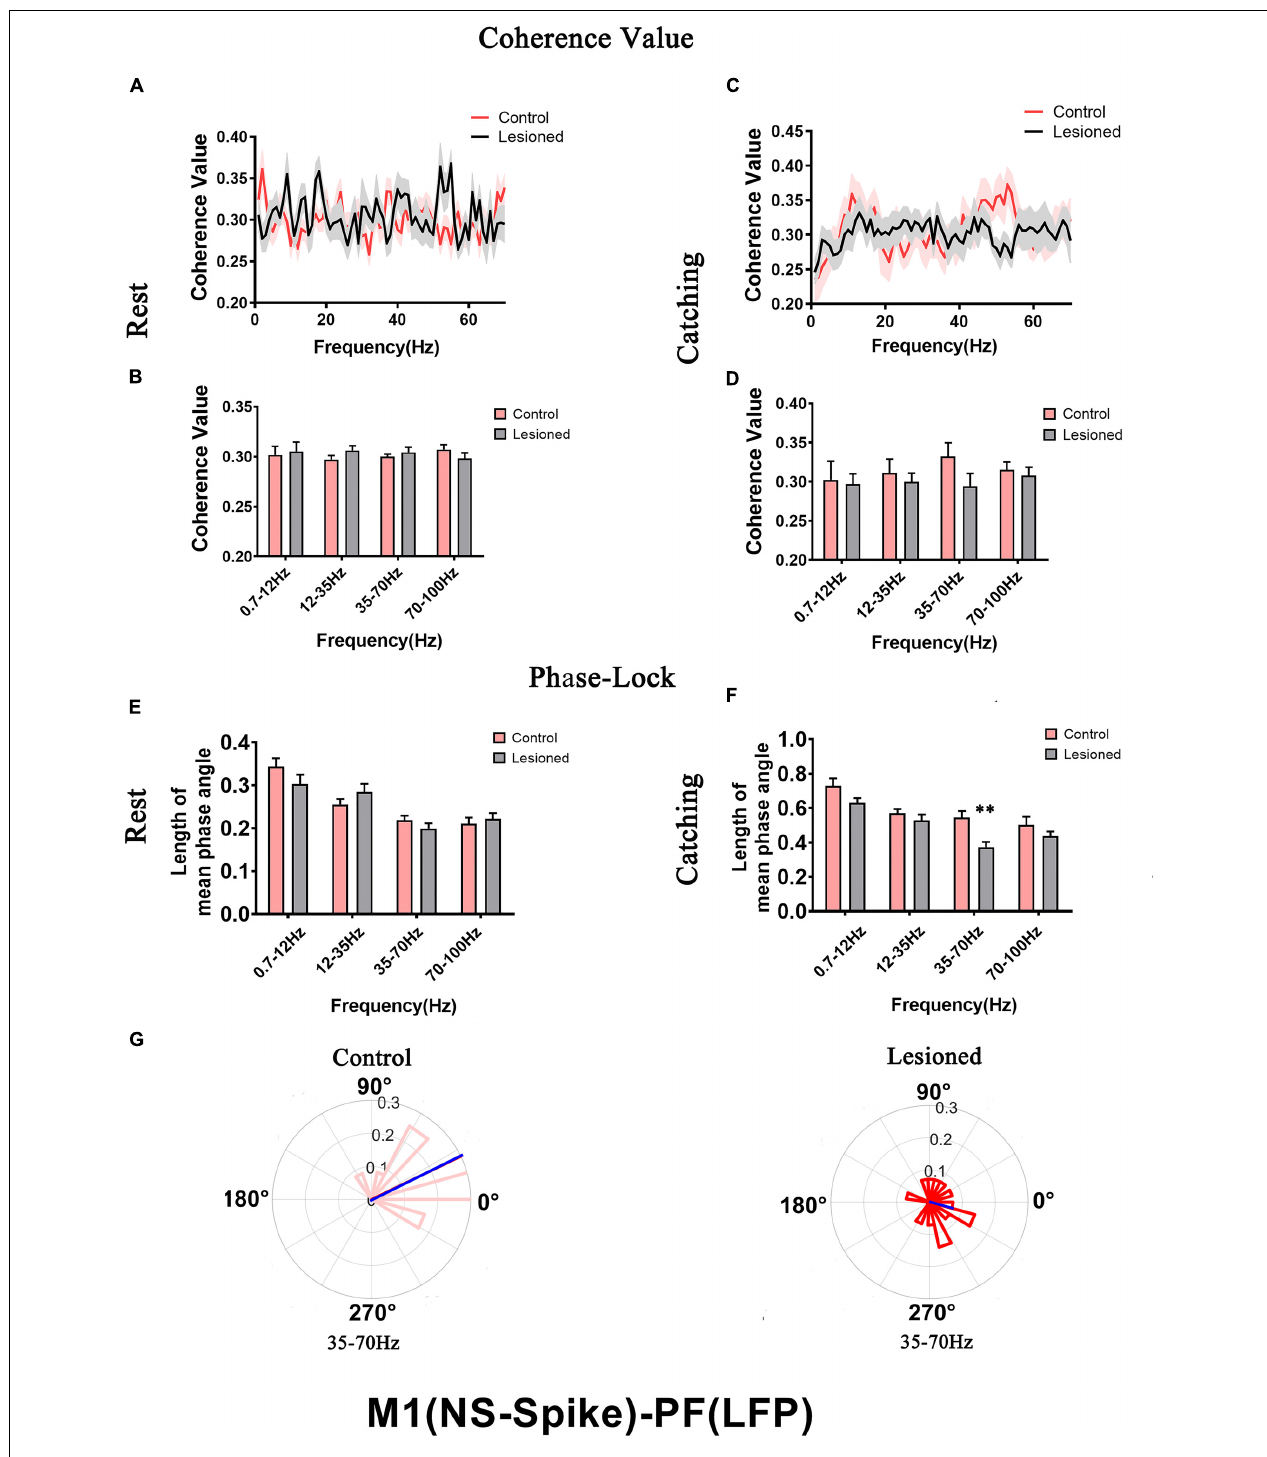
FIGURE 10 | Coherence values and phase-lock of NS with respect to PF-LFPs in the control rats and the DA-lesioned rats. Coherence values between NS ( n = 25 neurons from 16 lesioned rats, and n = 27 neurons from 14 control rats) and PF-LFP have no alterations during (A,B) rest and (C,D) catching movement states. During resting, NS neurons in the lesioned rats did not significantly change in the length of mean phase angle compared to that of neurons in the control rats (E) . Blue lines radiating from the center indicated the measure of the strength of concentration of the distribution of the mean phase angle of all recording NSs. During catching movements, the length of mean phase angle was significantly lower in the range of 35–70 Hz in the lesioned rats (dark red) compared to the control rats (light red) (F,G) . Data are expressed as the mean ± SEMs ( ∗∗ p < 0.01).